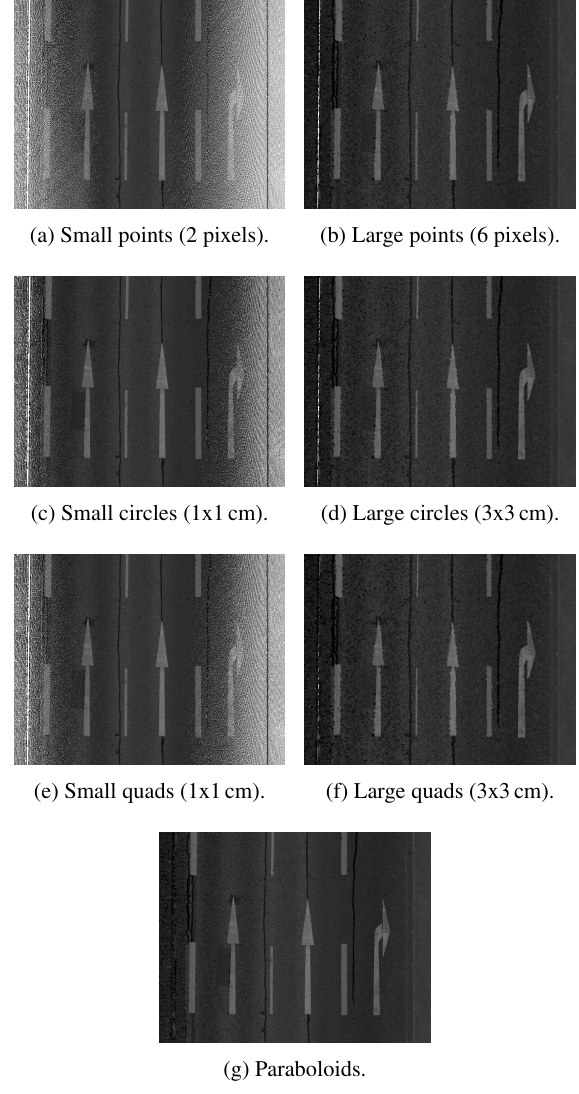
Figure 4. Point cloud rendered with different